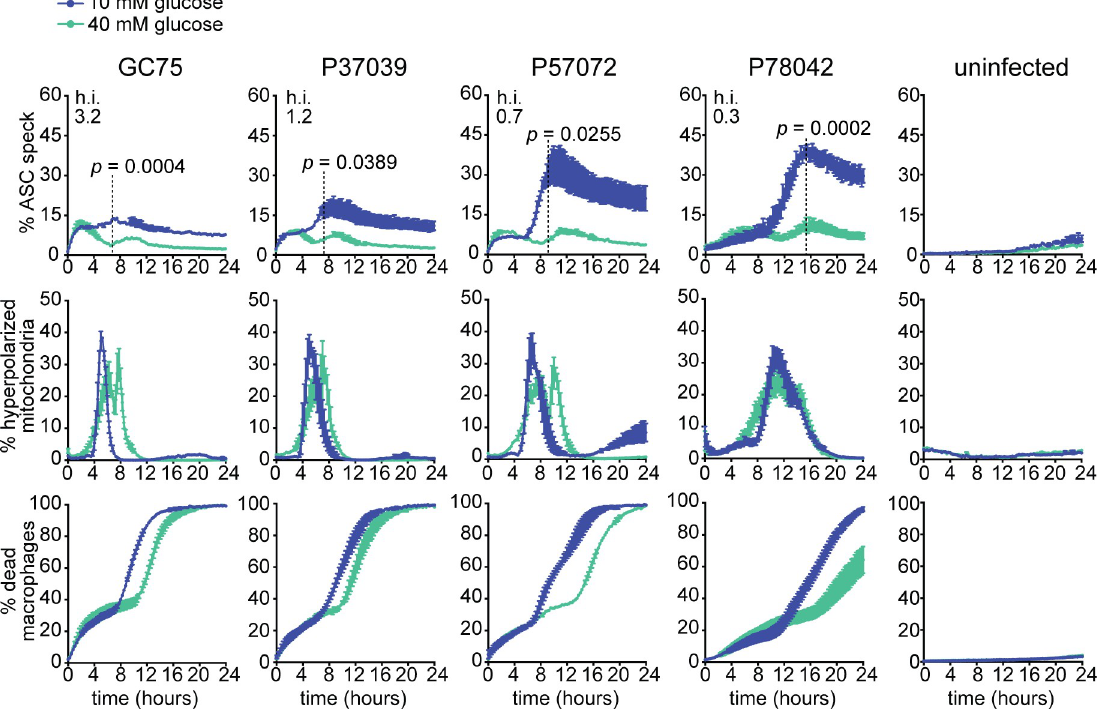
Fig 7. Glucose starvation is a broadly relevant mechanism of inflammasome activation across diverse C . albicans isolates. ASC- mCerulean-expressing immortalized macrophages were infected with the indicated clinical isolates of C . albicans at MOI 6:1. Tissue culture media contained 10 or 40 mM glucose. Shown are % macrophages containing an ASC speck, % macrophages with hyperpolarized mitochondria and % dead macrophages as quantified in live cell imaging experiments. Data are the mean values and SEM from 2 independent experiments involving at least 8000 macrophages surveyed for each condition, per experiment. The hyphal index (h.i.) for the C . albicans strains is shown in the right top corner of the graphs. p values were calculated for % ASC speck at the time points indicated by dashed lines (Student’s two-tailed t test).